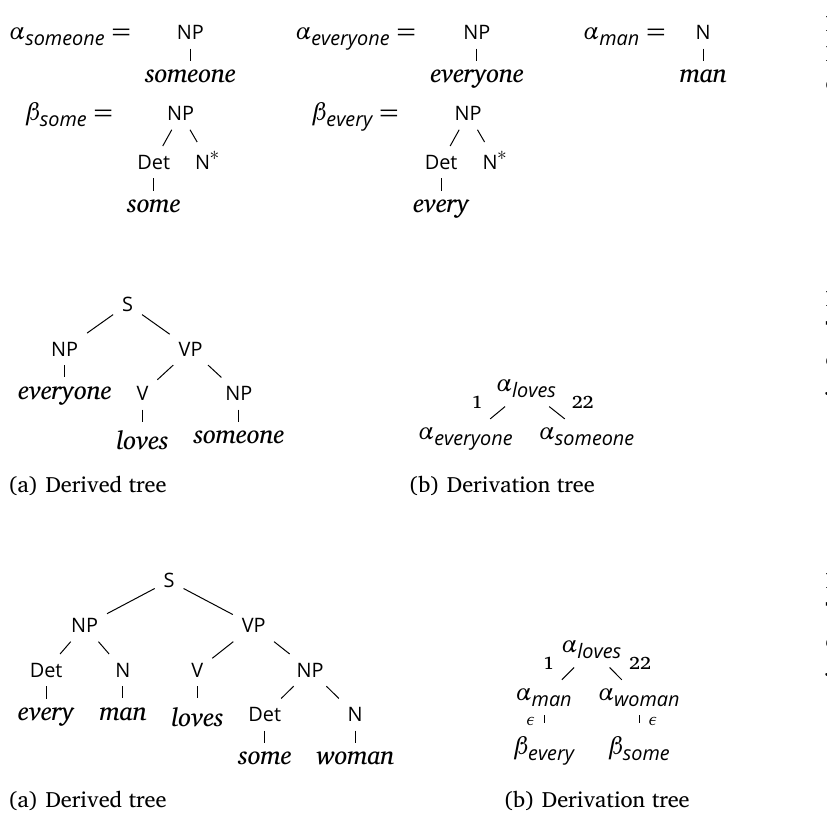
Determiners and quantifiers